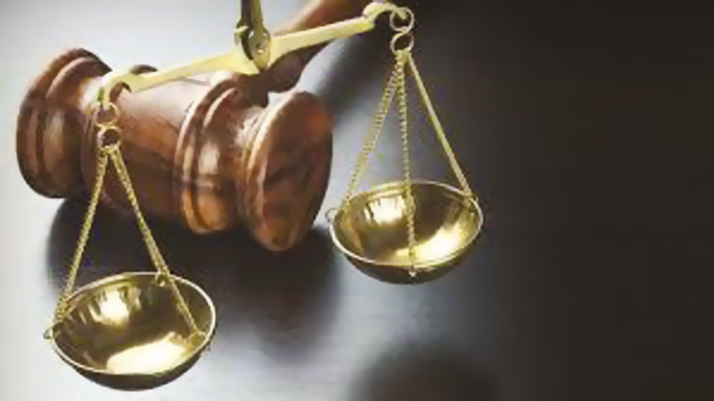
(c) Source: BoerenbusinessDescription (a), (b) and (c): Animal welfare, consumer welfare and competition law.